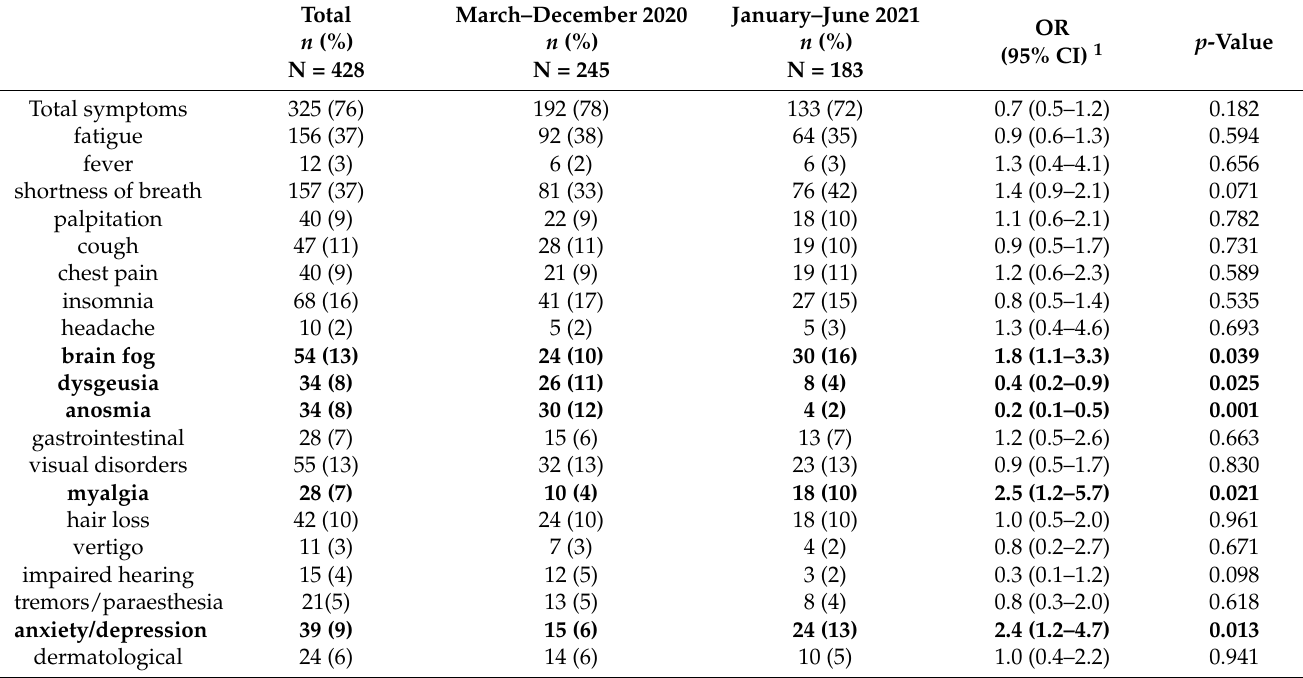
Table 3. Comparison of symptom frequencies in March–December 2020, corresponding to the period of prevalent circulation of original Wuhan SARS-CoV-2 strain in Italy, with those from patients infected in the period January–April 2021 (prevalent circulation of B.1.1.7 Alpha